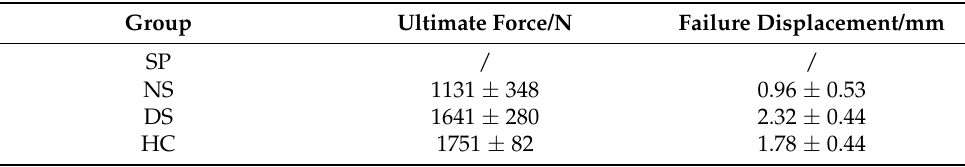
Figure 8. ( a ) Representative force–displacement curves and ( b ) average ultimate forces and failure displacements for the joints with different surface structures. Table 4. Mechanical properties of joints with different surface structures.